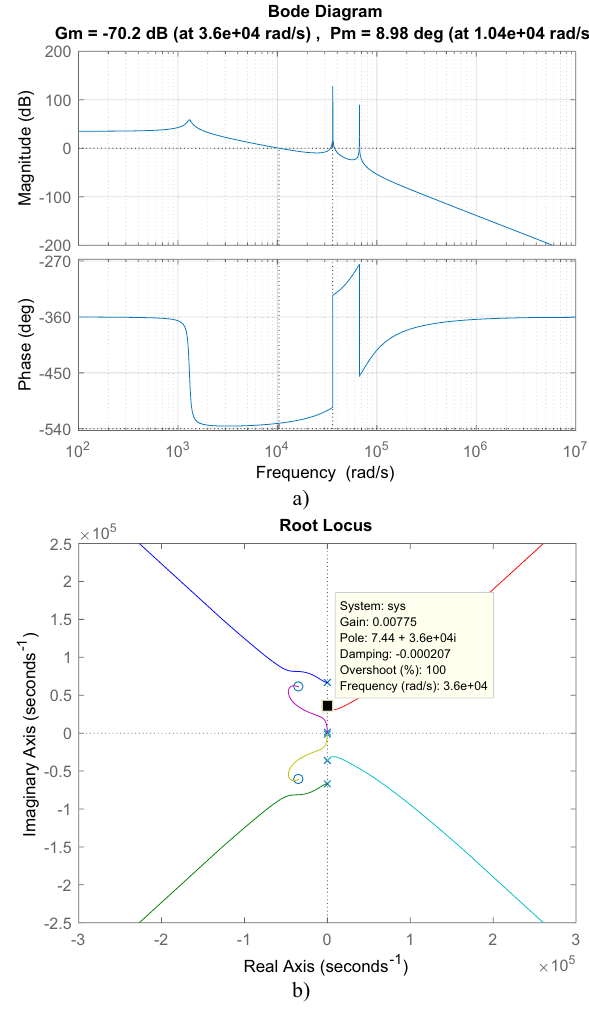
Figure 9. For LC DM filter with isolated Ćuk PFC ( a ) Bode diagram, ( b ) root locus graph.